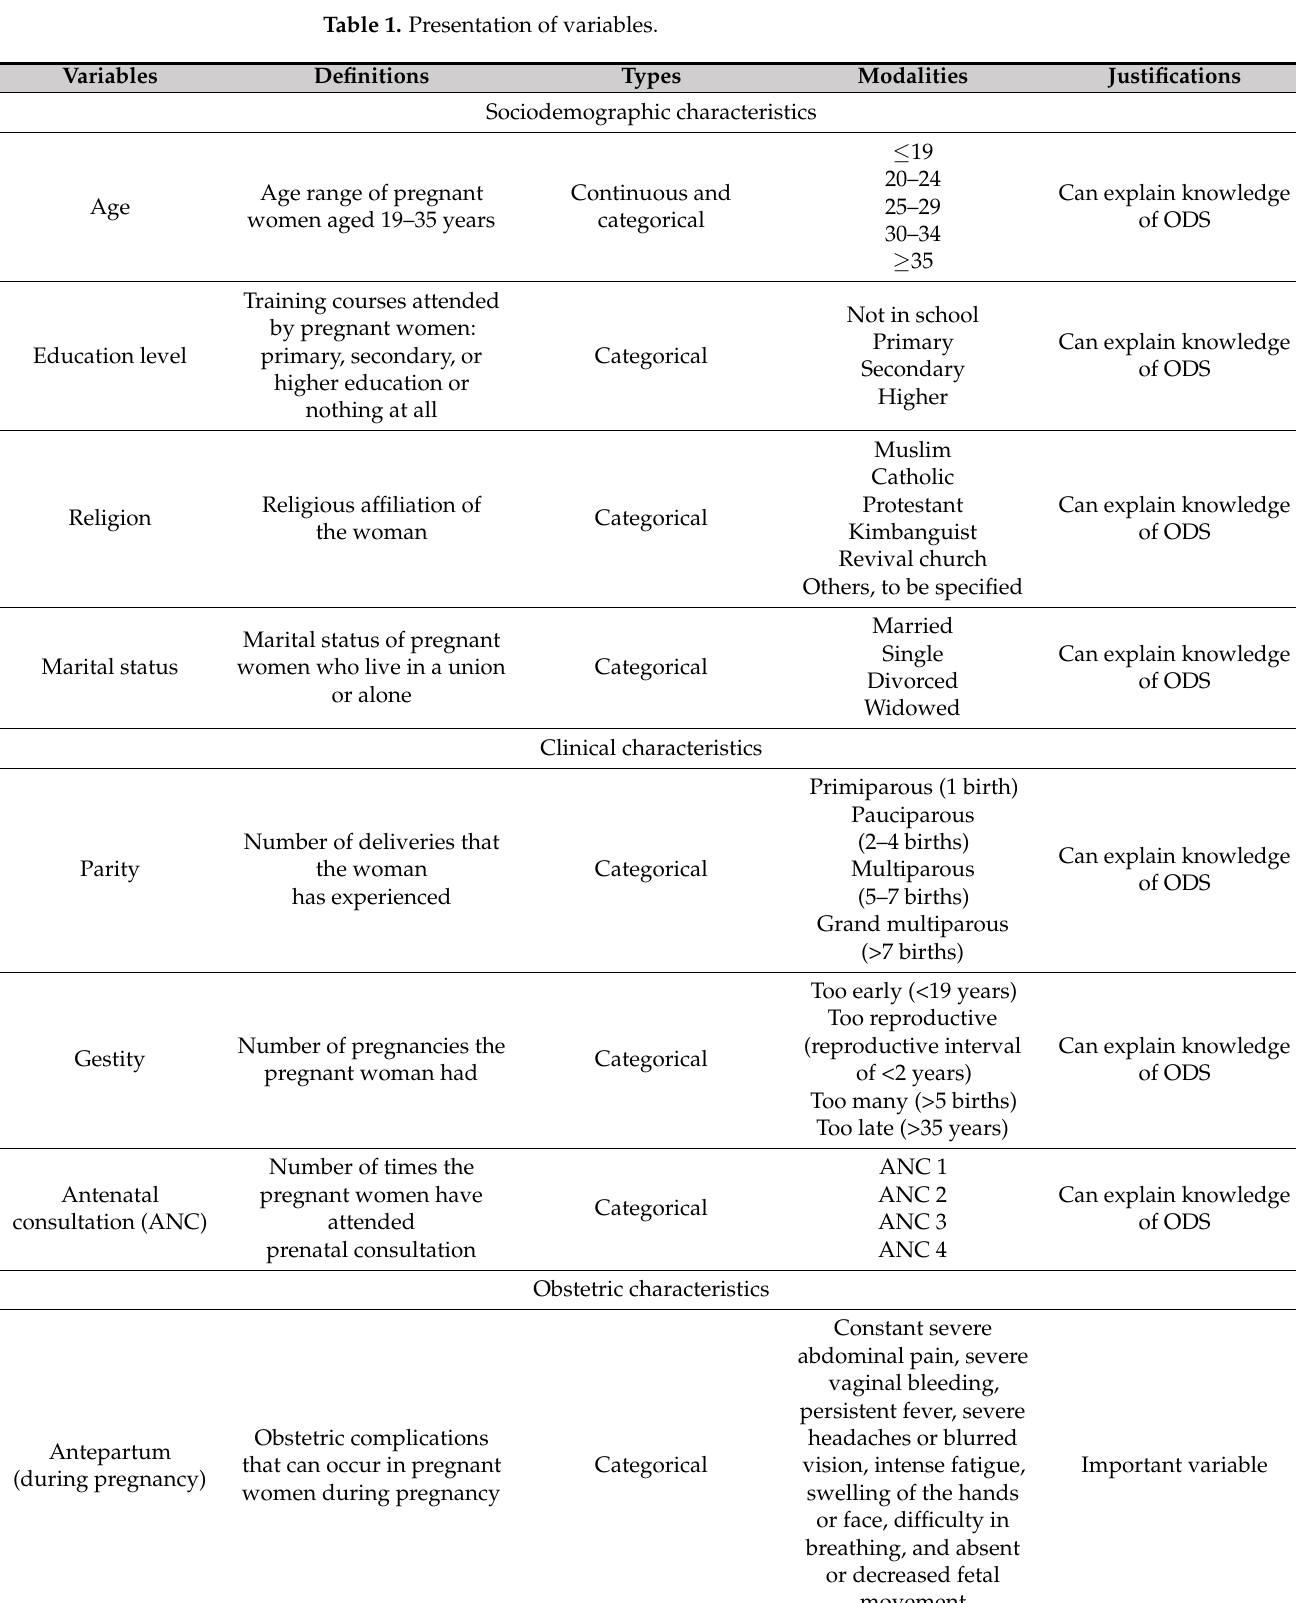
Table 1. Presentation of